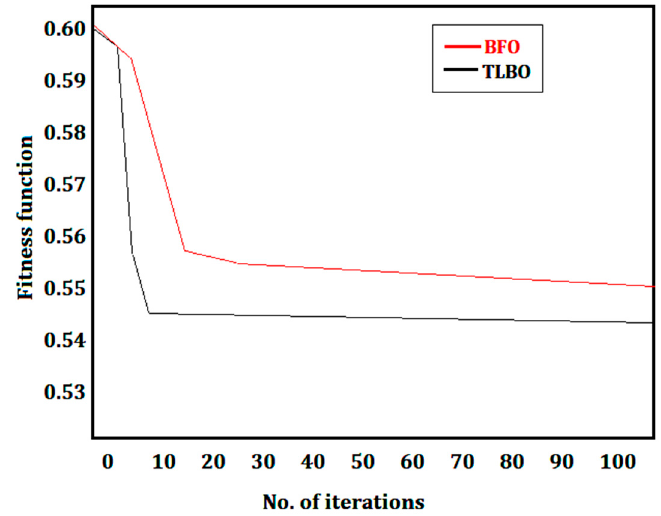
Figure 4. Convergence of bacteria foraging optimization (BFO) and teaching–learning-based optimization